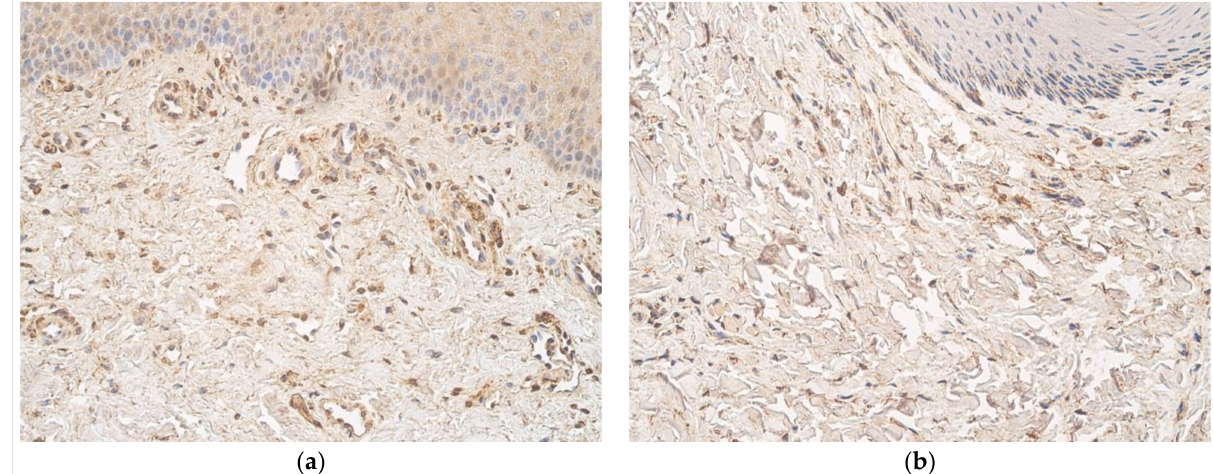
Figure 3. Immunohistochemical micrographs of M1 in a cleft affected lip tissue and in a control subject. ( a ) Moderate positive M1 cells (++) in the connective tissue of the cleft lip tissue sample in a three months old child with a cleft lip and palate. M1 IMH, × 250; ( b ) Occasional positive M1 cells (0/+) in the control group tissue sample of a six years old child. M1 IMH, × 250.